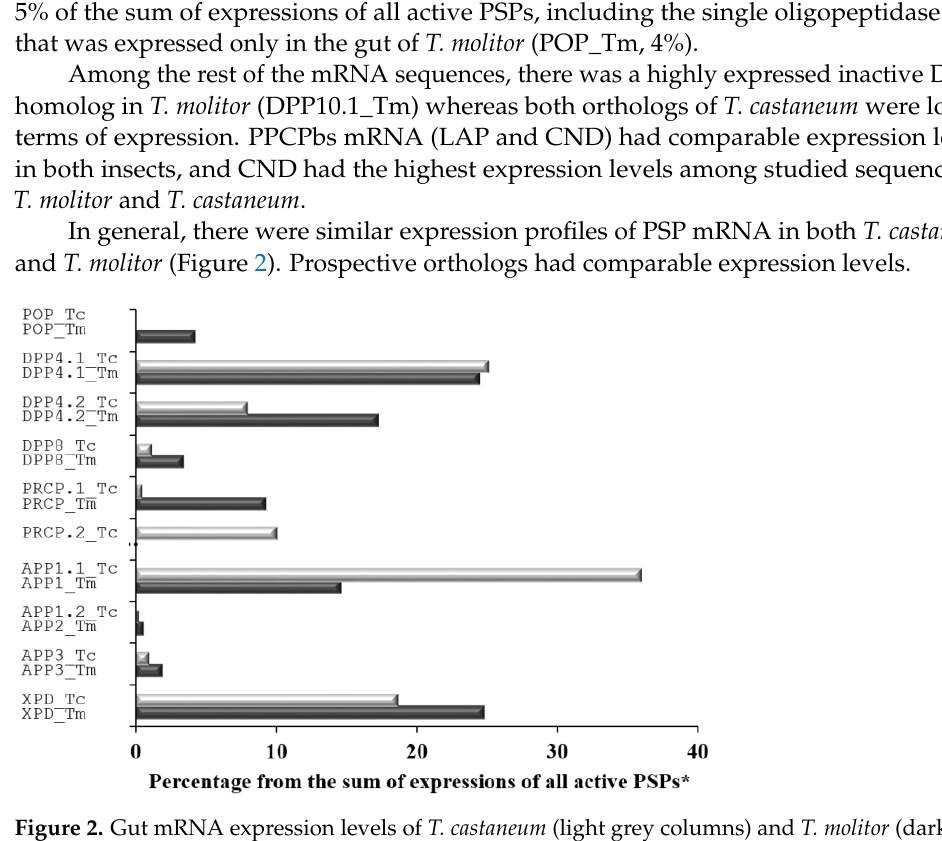
Figure 2. Gut mRNA expression levels of T. castaneum (light grey columns) and T. molitor (dark grey columns) active PSPs. * This calculation involved only active PSPs: POP, DPP 4, DPP 8, PRCP, APP1, APP2, APP3, and XPD. DPP 10 was not included because it is an inactive DPP 4 homolog and does not possess peptidase activity. LAP and CND were not included because cleavage of post-proline bonds is not their main specificity.